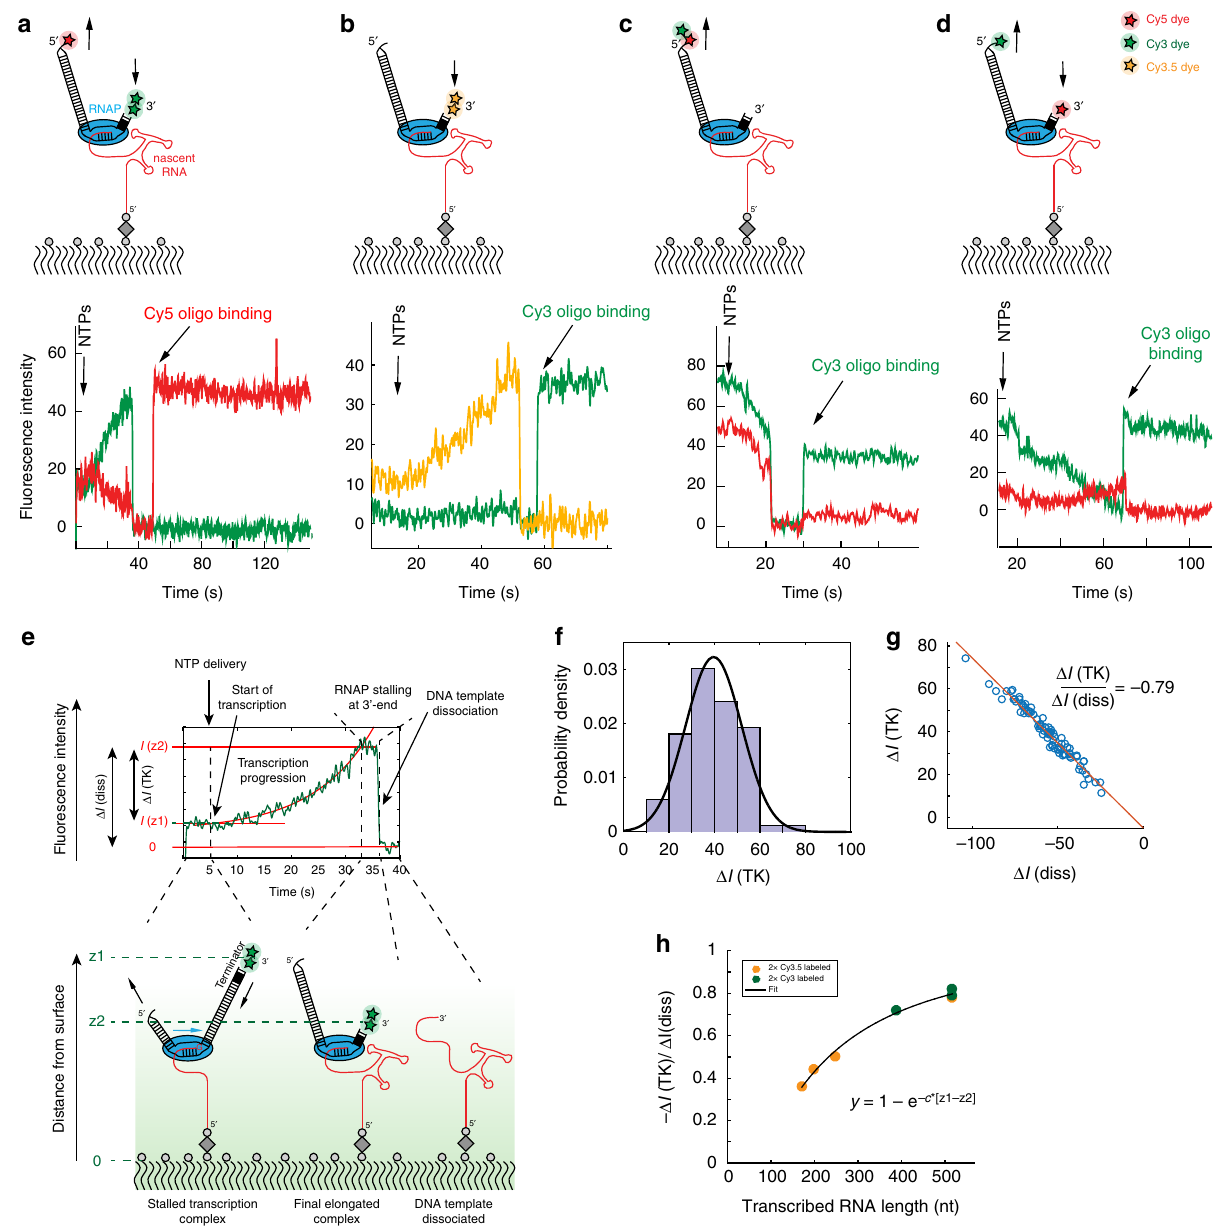
Fig. 2 Transcribing within the evanescent fi eld. a – d Different DNA template labeling schemes result in different fl uorescence intensity pro fi les. The DNA template labeling schemes are shown at the top of each trace with arrows showing the movement of the corresponding dyes towards or away from the surface during transcription progression resulting into a fl uorescence intensity increase or decrease, respectively. The times of NTP injection and of labeled DNA oligo binding are indicated with arrows. The DNA oligo binds to the 3 ′ -end of the nascent RNA and thereby scores for full-length RNA as illustrated in Fig. 1. Note that the characteristic fl uorescence intensity changes also allow using a single color for monitoring transcription progression and scoring of full- length RNA with the labeled DNA oligo, i.e. Cy3 in ( c , d ). 532 nm and 642 nm lasers were used to excite the Cy3 and Cy5 dyes, respectively ( a , c , d ). A single laser at 532 nm was used to excite both the Cy3 and Cy3.5 dyes ( b ). e The total fl uorescence intensity change during transcription, Δ I(TK), is related to the dye position change along the evanescent fi eld. Δ I(diss) denotes the intensity change upon DNA template dissociation. f The absolute fl uorescence intensity change during transcription widely varies between transcribed RNA molecules of the same size due to inhomogeneous illumination intensity across the ZMW chip. g Normalizing the intensity change during transcription by the intensity change during DNA template dissociation results in a nearly constant value (slope of curve) for all the molecules of the same length. h The normalized intensity change during transcription relates to the transcribed RNA length by a model in which the DNA template moves within the evanescent fi eld (see Supplementary Fig. 2 and Supplementary Note 2). For ( f , g ), a 517 nt RNA was transcribed from a DNA template labeled as shown in ( e ); Number of molecules analyzed ( n ) = 83 ( f , g ) and ( n ) = 109, 65, 78, 72, 53, 70, 83 for the data points at 171, 199, 247, 388, 517, 517 and 517 nts transcribed RNA lengths ( h ). Source data are provided as a Source Data fi